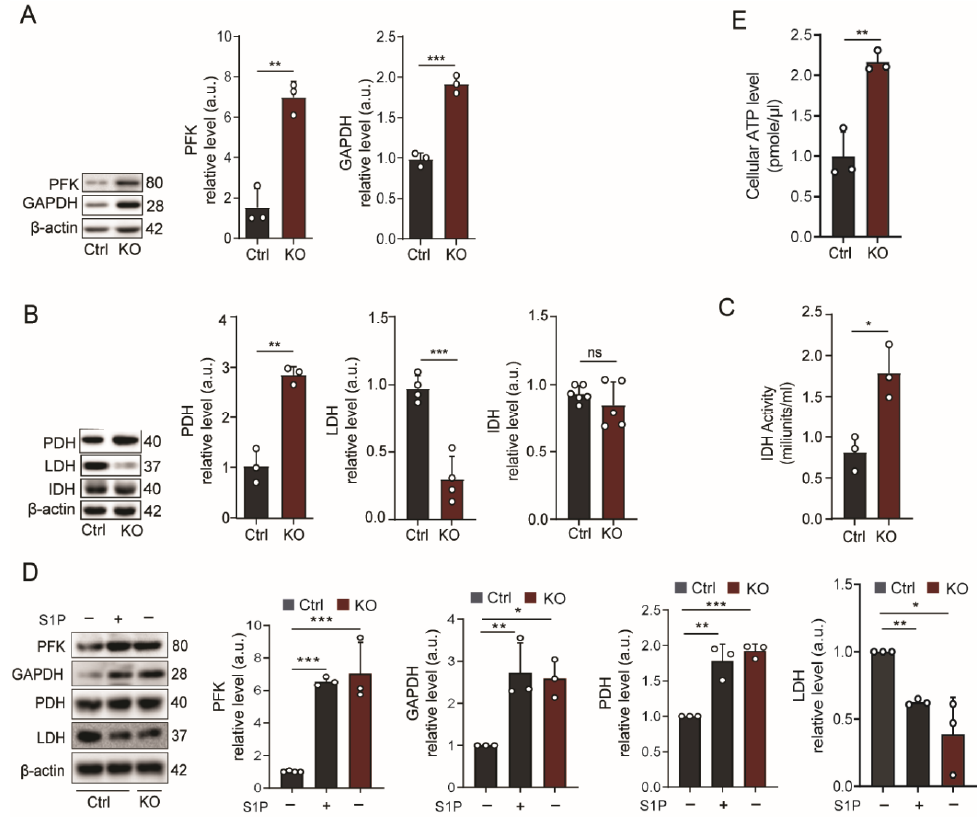
Figure 1. Neural SGPL1 ablation triggers glucose degradation in primary cultured astrocytes. ( A , B ) Protein quantification of phosphofructokinase (PFK), glyceraldehyde-3-phosphate dehydrogenase (GAPDH), pyruvate dehydrogenase (PDH), lactate dehydrogenase (LDH), and isocitrate dehydro- genase (IDH) in astrocytes from control (Ctrl) or SGPL1 fl/fl/Nes (KO) mice, as indicated. ( C ) IDH activ- ity measurement. ( D ) Protein quantification of the indicated enzymes following stimulation (+) of control astrocytes with exogenous S1P (10 nM, 24 h), ( − ) represents without stimulation ( E ) Quanti- fication of ATP in cultured astrocytes derived from control (Ctrl) and SGPL1 fl/fl/Nes (KO) mice. For all, representative immunoblots are shown with β -actin as loading control. Bars represent means ± SEM, n ≥ 3, unpaired Student’s t- test, one-way ANOVA with Bonferroni multiple comparison test; * p < 0.05, ** p < 0.001, *** p < 0.0001, ns not significant.